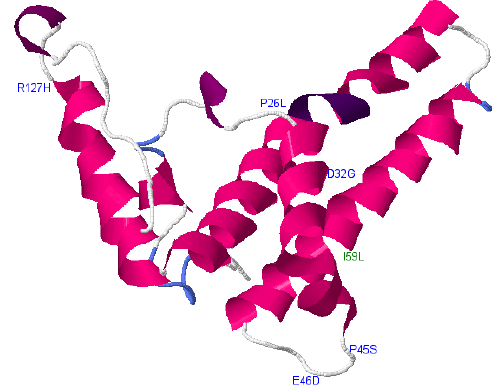
Figure 2. Mutations within the core region of subgenotype A1.